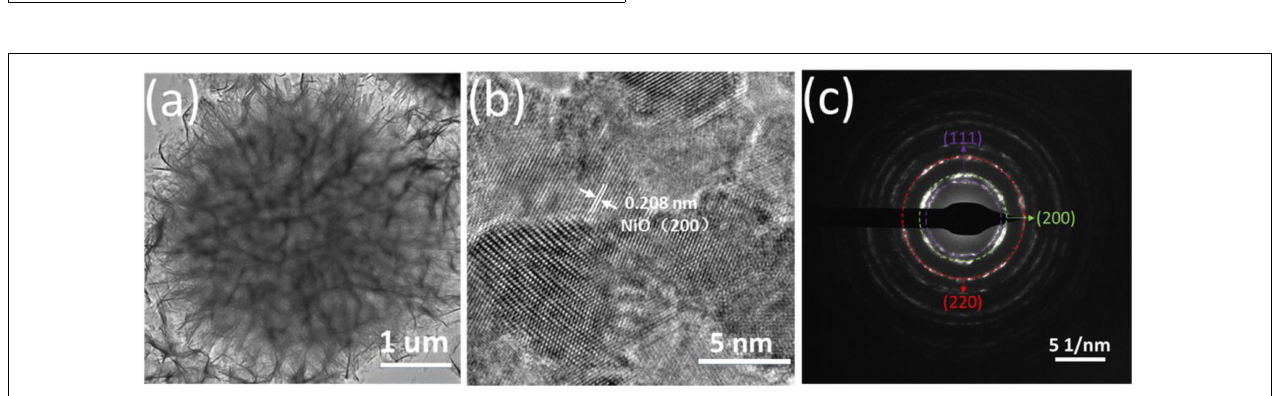
FIGURE 4 | (a) TEM image of NiO; (b) HRTEM image of NiO; (c) SAED pattern of